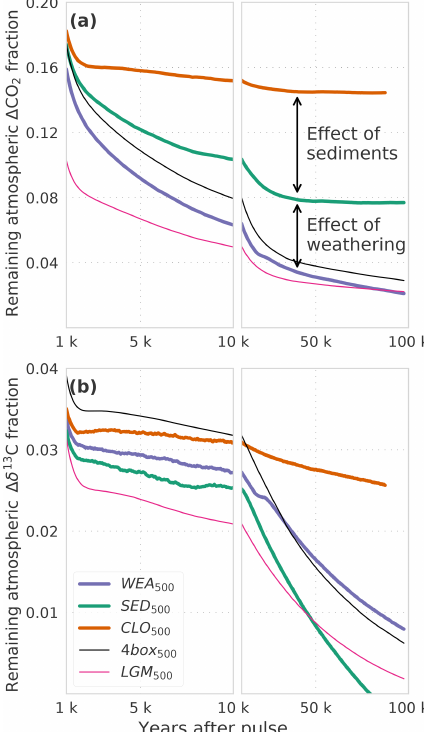
Figure 2. (a) CO 2 and (b) δ 13 C perturbations in the atmosphere for the factorial simulations WEA 500 , SED 500 , CLO 500 , 4box 500 , and LGM 500 . Shown is the time interval 1 to 100kyr. Data are filtered with a moving average of 1000 years in the interval 1–10kyr and 5000 years in the interval 10–100kyr for better visibility. Note that experiment CLO 500 was run for 90kyr instead of